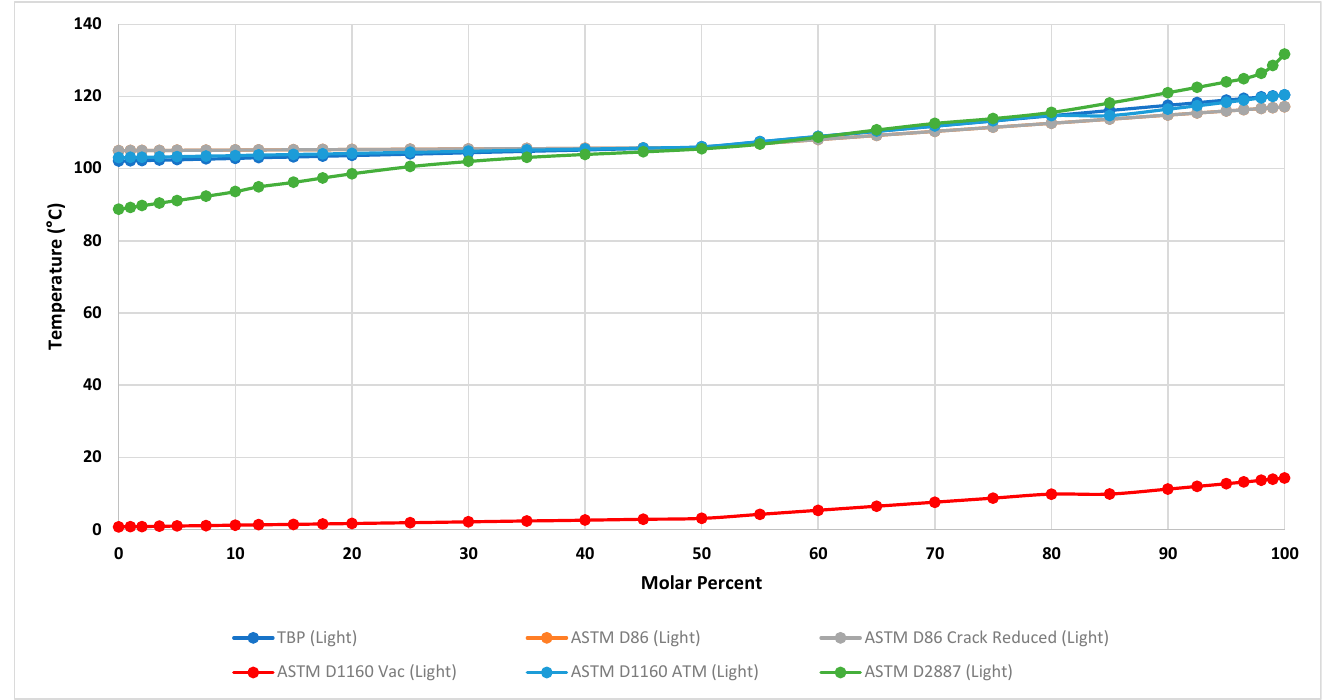
Figure 2. Boiling point curves of precipitated LDPE.